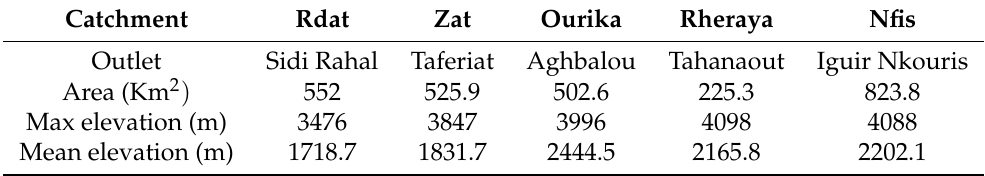
Table 1. The outlet of each